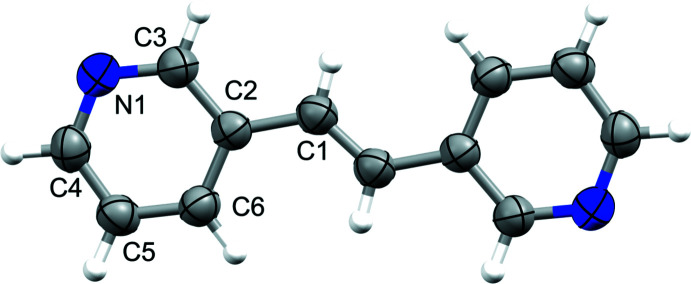
Single crystal structure for trans-bis­(pyridin-3-yl)ethyl­ene (3,3′-bpe) with anisotropic displacement ellipsoids at 50% probability.